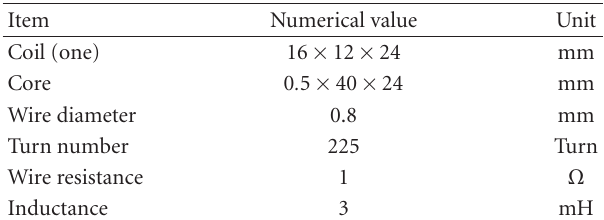
Table 3: Specifications of electromagnet.